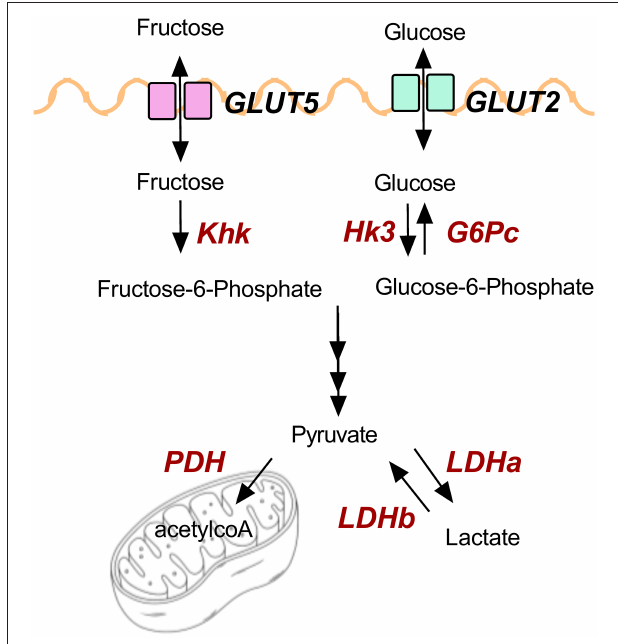
FIGURE 6 | Illustration of genes and products involved in carbohydrate metabolism.